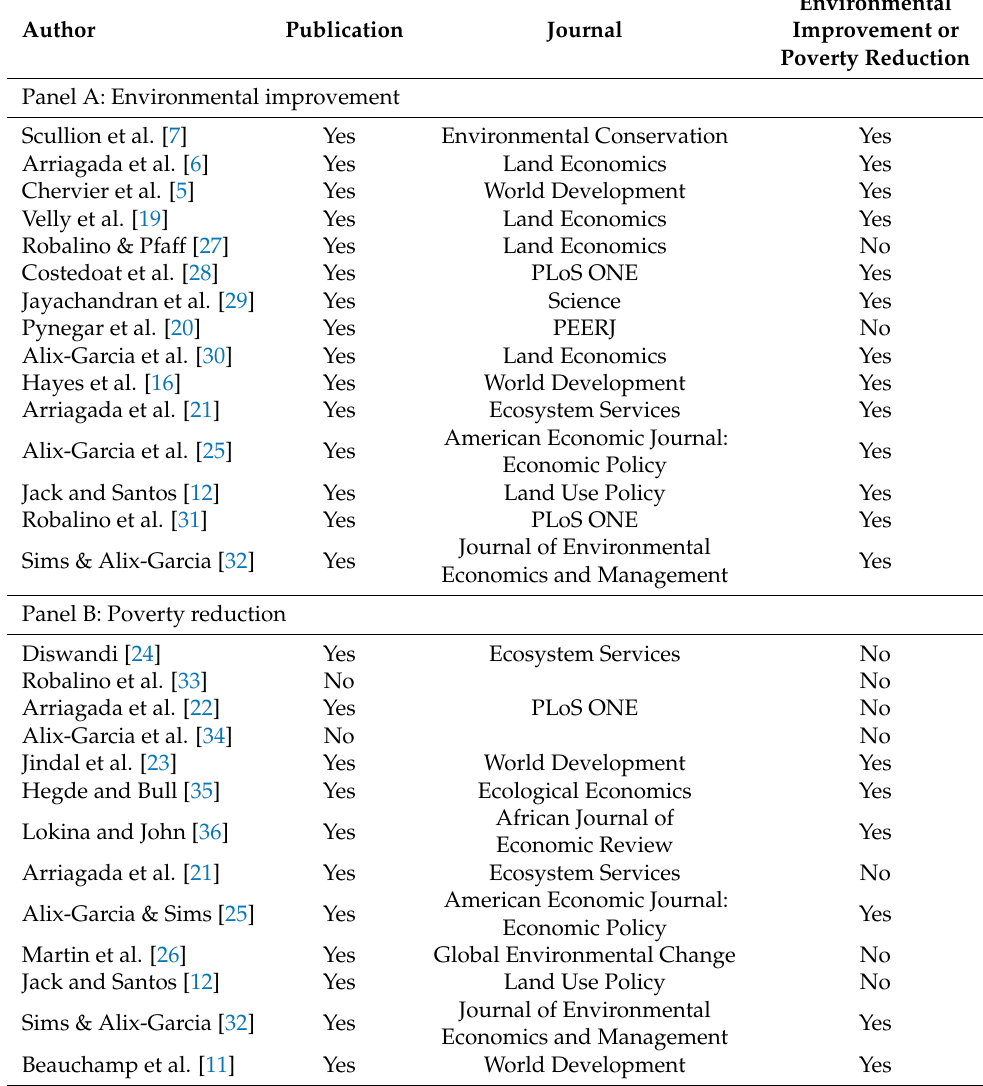
Table 2. Empirical literature on environmental improvement and poverty reduction effects of